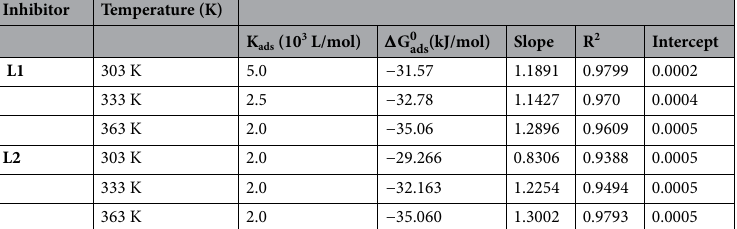
0 Table 2. (cid:31) G ads and K ads obtained from Langmuir Isotherm onto mild steel HCl (0.1 M) at varying concentrations, and temperatures of 303 K, 333 K and 363